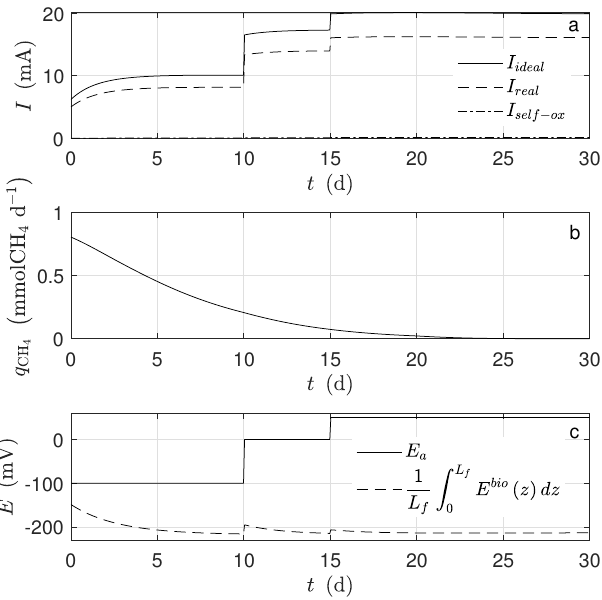
Figure 4. Numerical solution for the MEC model during chronoamperometry operation. ( a ) Current, ( b ) methane production, and ( c ) potential applied and average